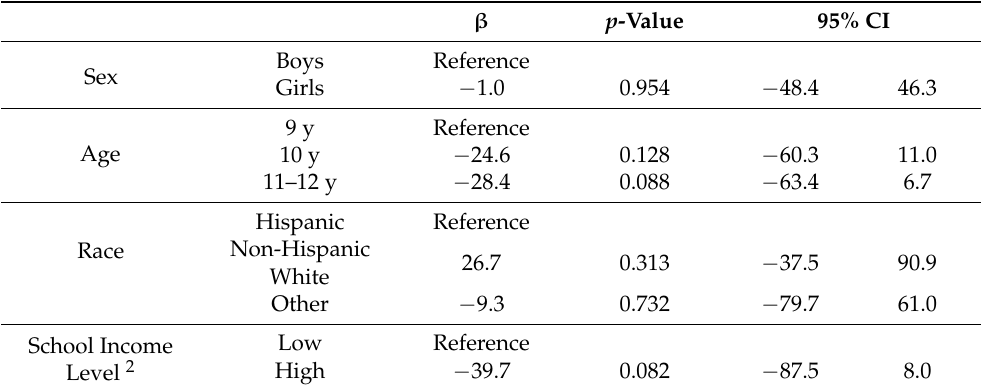
Table 2. Results from linear regression models examining the association between Veggie Meter scores and demographic characteristics ( n = 143) 1 . β p -Value 95% CI Boys Reference Sex